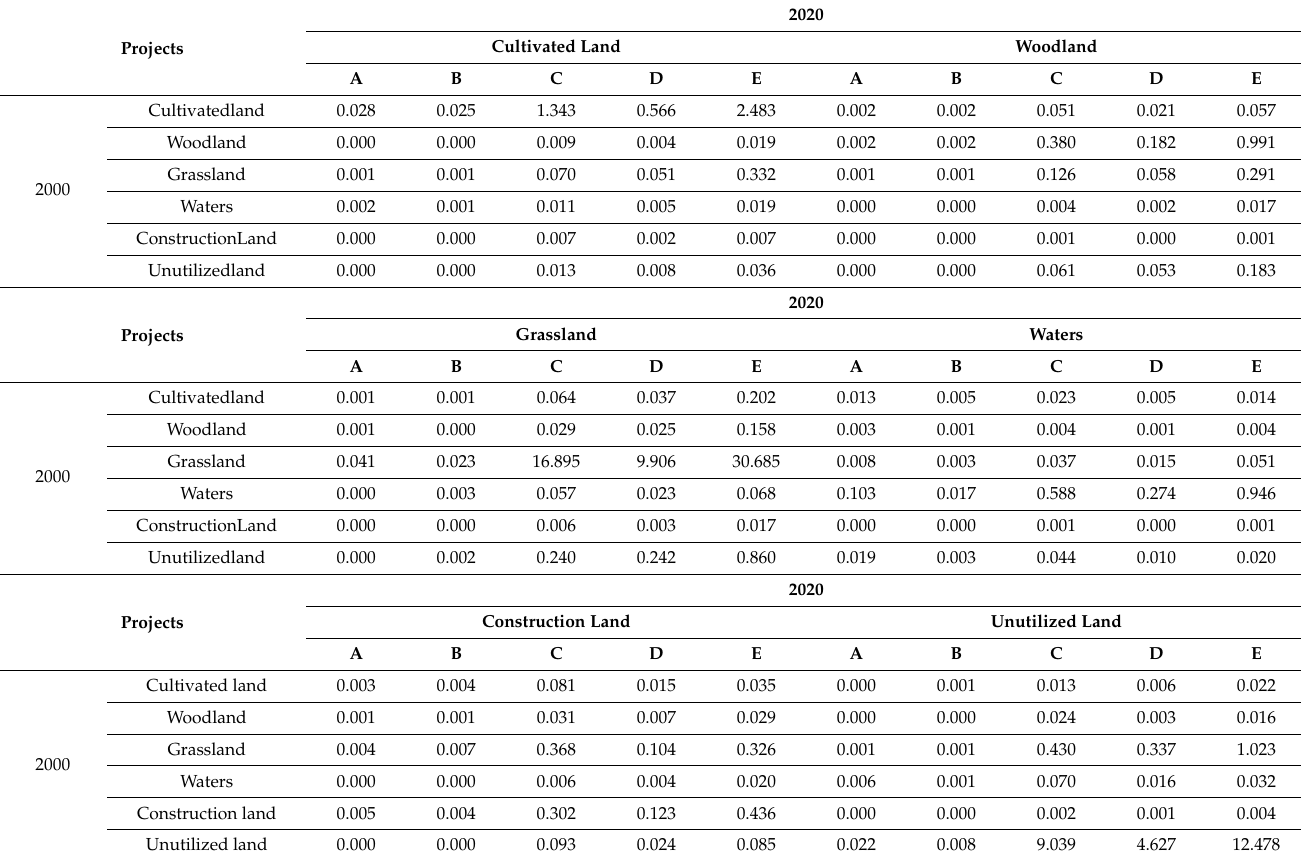
Table 4. Land use types and proportions corresponding to the significance of different trends. A: Extremely significant degrada-tion; B: Significant degradation; C: No significant change; D: Significant improvement; E: Extremely significant